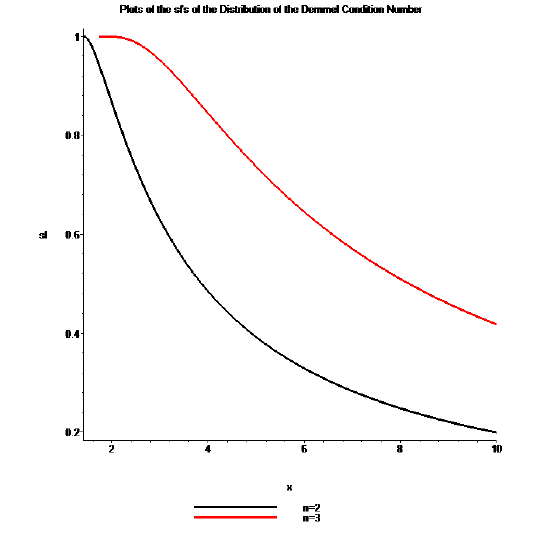
√ 2 ≤ x ≤ 1000 and n = 3 ,